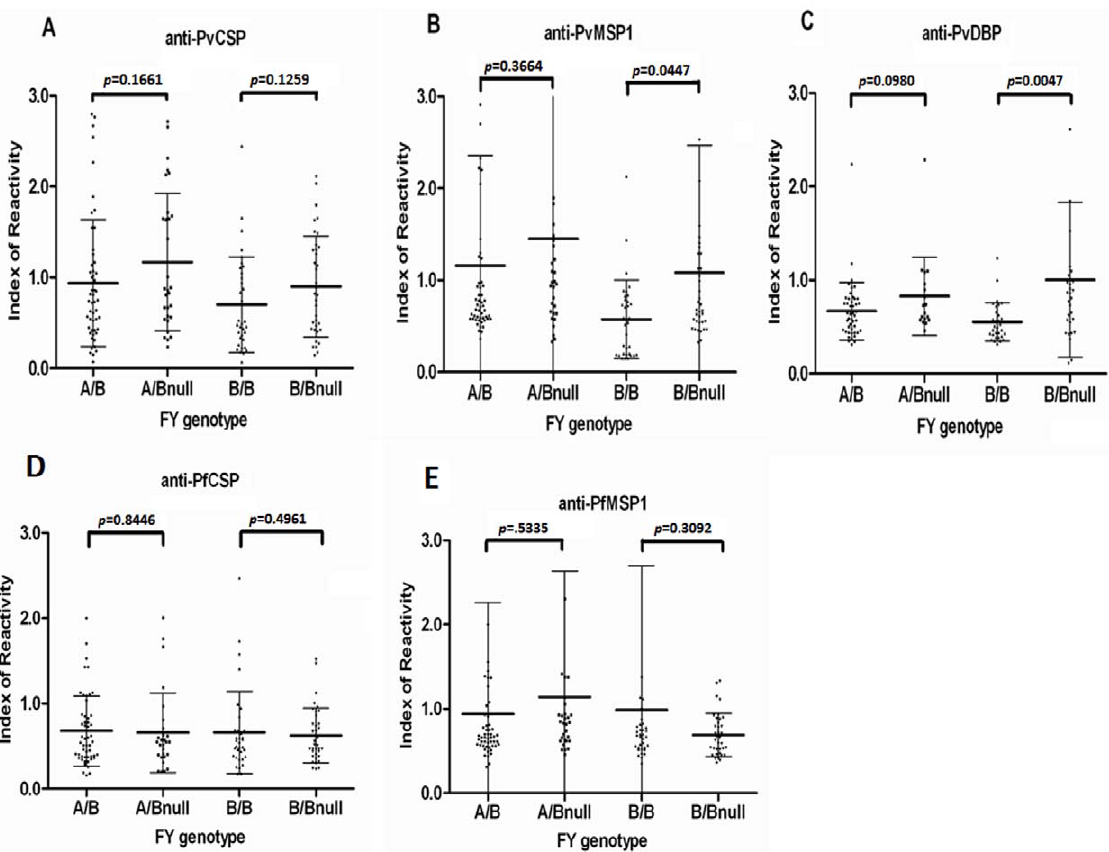
Figure 3. The levels of antibody responses against P.vivax erythrocytic antigens differ among different Duffy genotypes. Immune recognition of P. vivax sporozoite antigen (A: PvCSP) and blood stage antigens (B: PvMSP1, C: PvDBP), or P. falciparum sporozoite antigen (D: PfCSP) and blood stage antigen (E: PfMSP1) by sera of donors with different Duffy genotypes FY*A/FY*B (A/B), FY*A/FY*Bnull (A/Bnull), FY*B/FY*B (B/B) and FY*B/FY*Bnull (B/Bnull). Values are expressed as Index of Reactivity (IR) that is calculated as test OD divided by cut-off OD. The cut-off OD is the average OD value of US donors (with no prior exposure to malaria) + 3 SD. The IR of donors with FY*A/FY*B genotype is compared with those of FY*A/ FY*Bnull, and FY*B/FY*B with FY*B/FY*Bnull using Student’s t -test and p values , 0.05 were considered